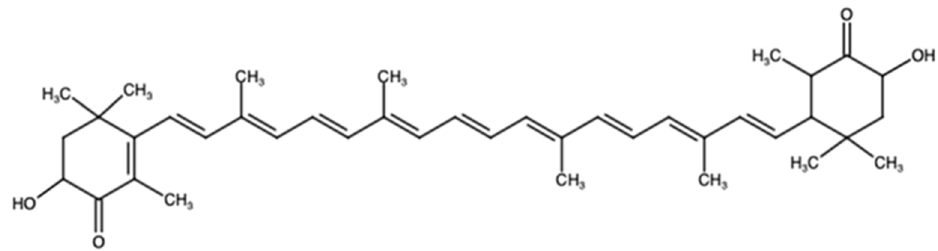
Figure 1. Astaxanthin’s non-stereochemical structural formula.